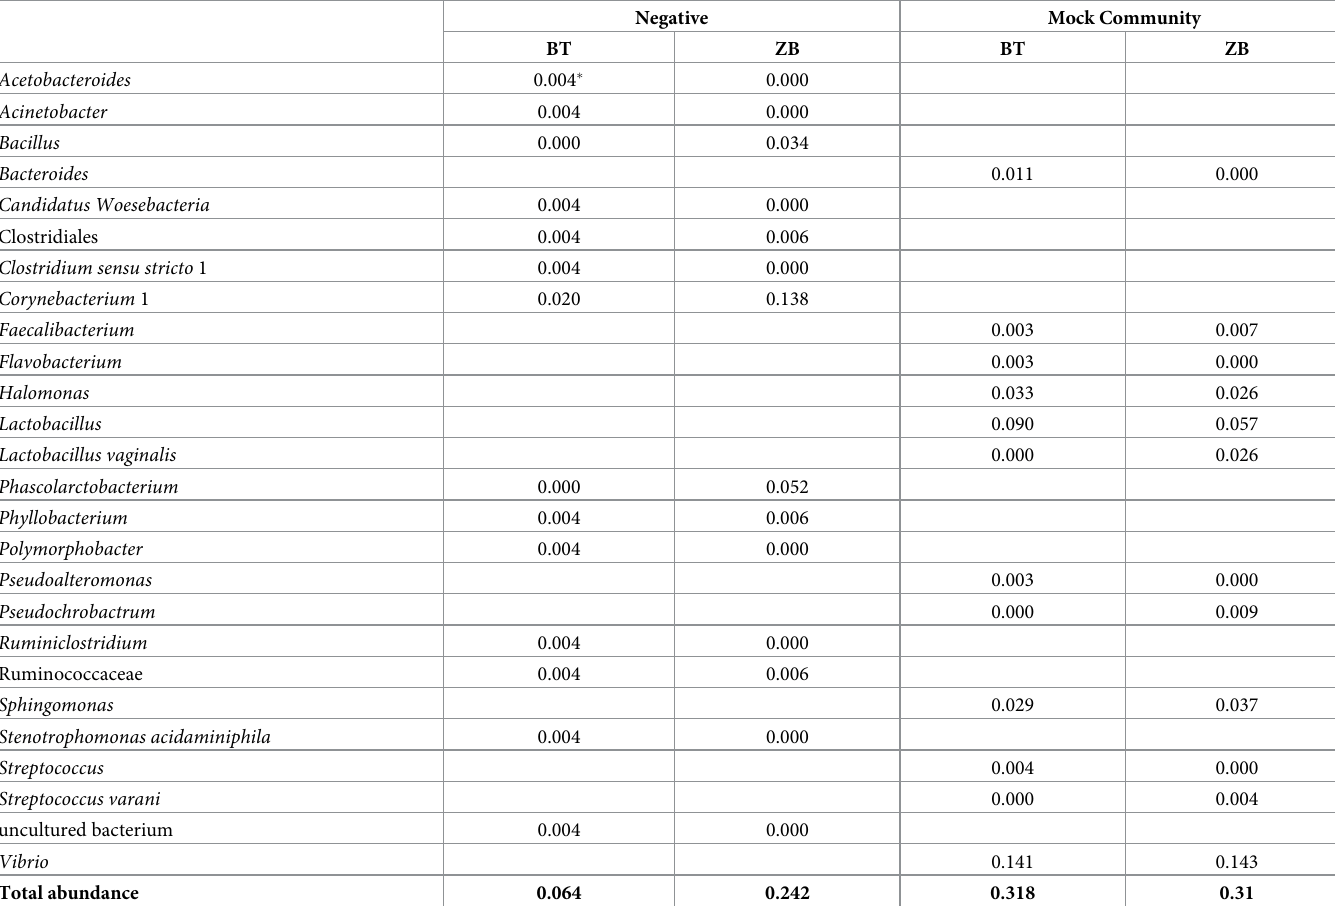
Table 1. Contaminants identified in negative and mock community controls.